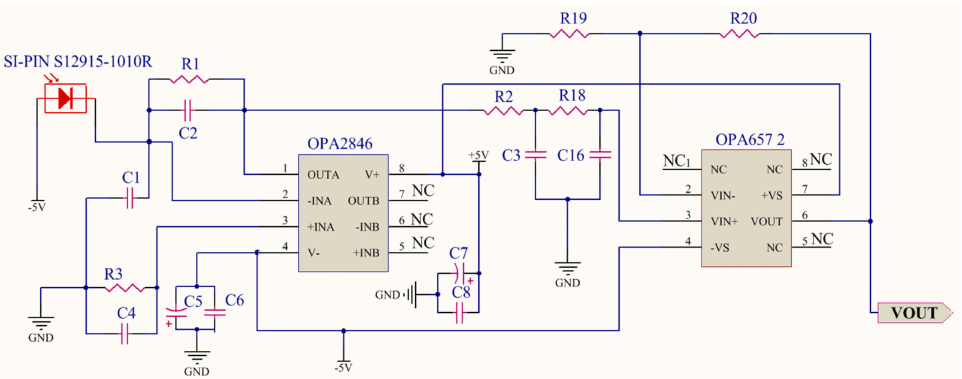
Figure 7. Schematic design of signal amplifier and filter of VLC